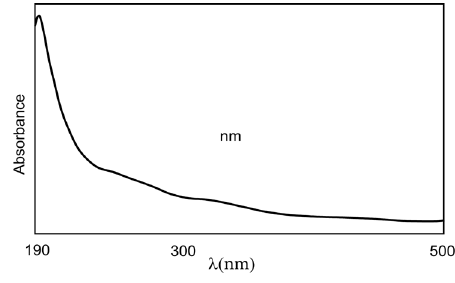
Fig. 4. UV spectrum of the